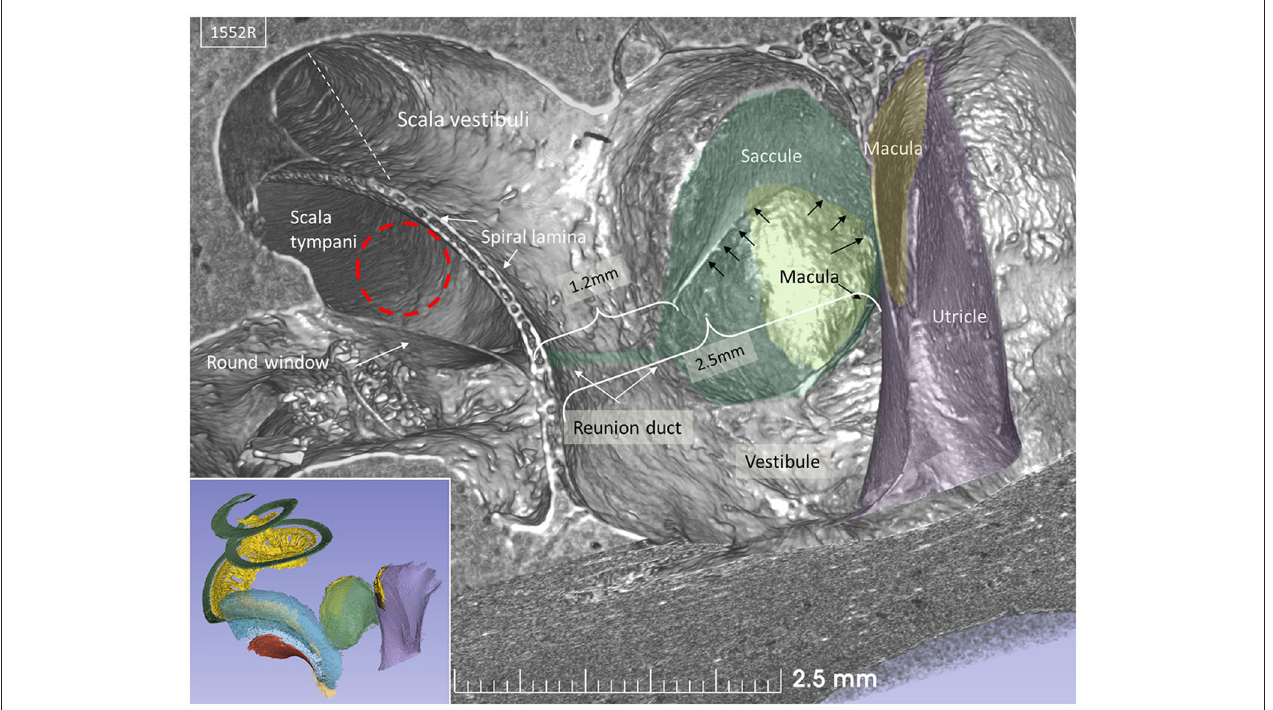
FIGURE 4 | SR-PCI section at the level of the RW and vestibule (lateral view). The RW and the position of a virtual electrode (dashed red line) are shown. The saccule lies in the spherical recess in the medial bony wall of the vestibule. It consists of a thicker and thinner part limited by thicker bands (arrows). The macula is stained yellow. The position of the RD is shown. Inset shows the modeled 3D anatomy with the saccule, RW (red), and spiral ligament of the cochlear base (blue). The broken line represents Reissner’s membrane.